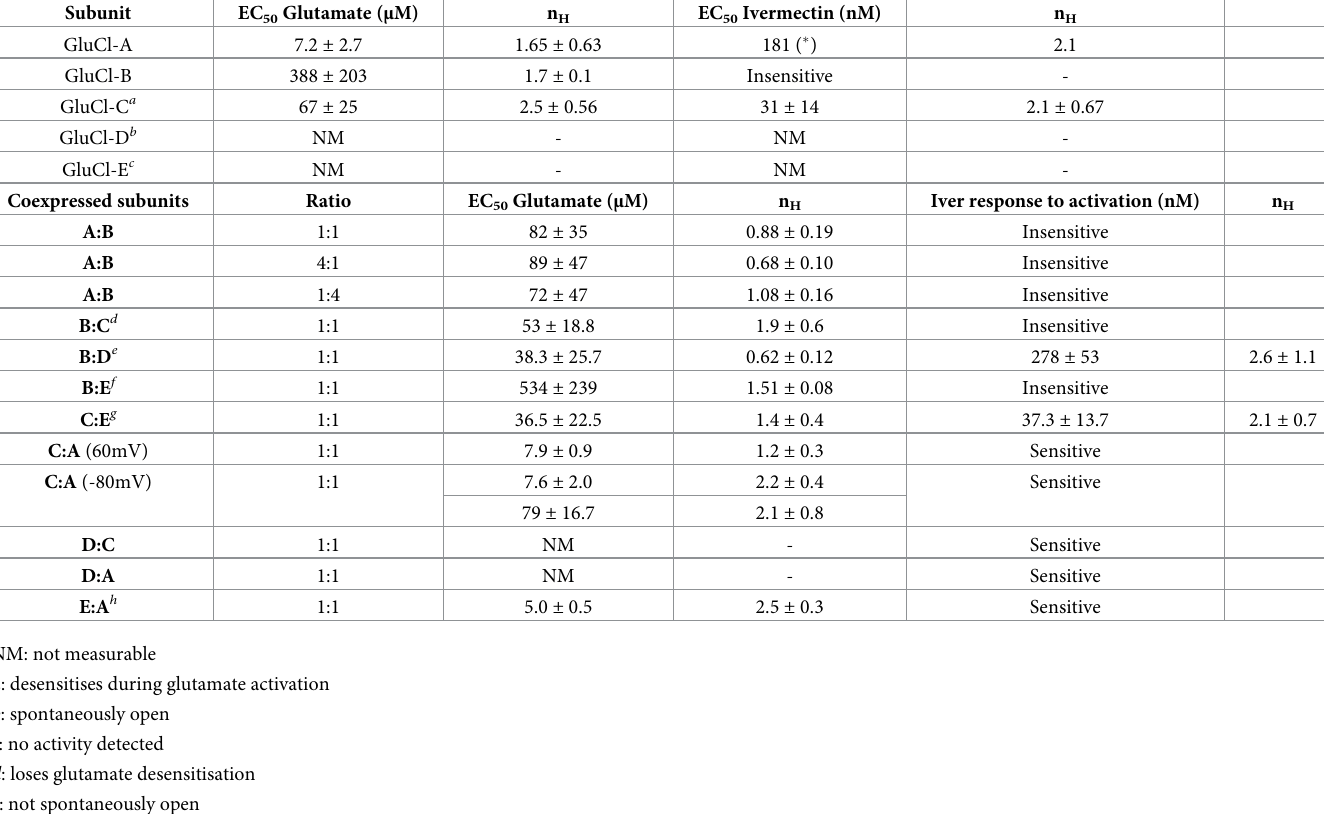
Table 2. Summary of glutamate and Ivermectin effects on CrGluCl subunits.